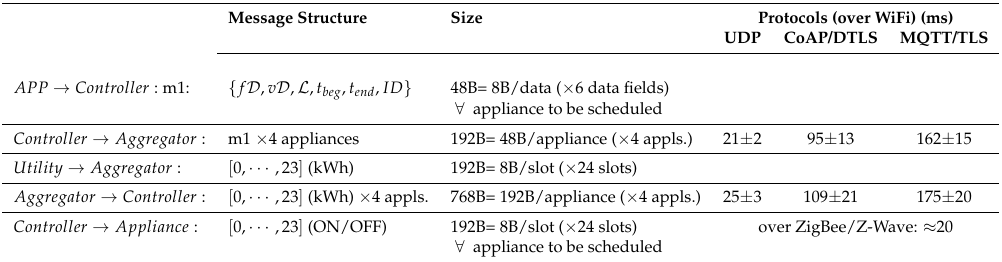
Table 3. Messages’ structure and size: Consumer on testbed comprised of 4 appliances. Headers and payload are depicted in Figure